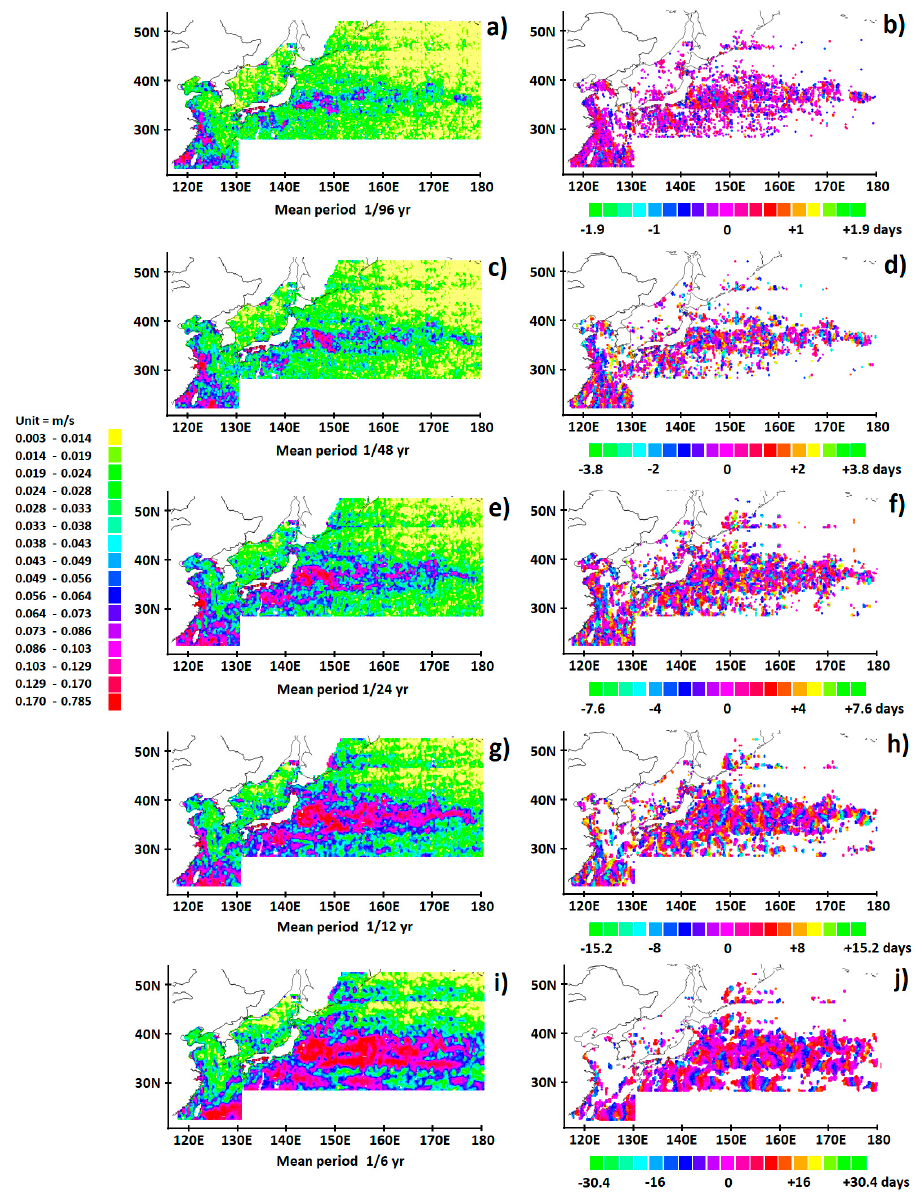
Figure 5. Same as Figure 3 for the amplitude ( a , c , e , g , i ) and the phase ( b , d , f , h , j ) of the meridional geostrophic current V oriented to the south when the time lag is zero. Same data sources as in previous figures.